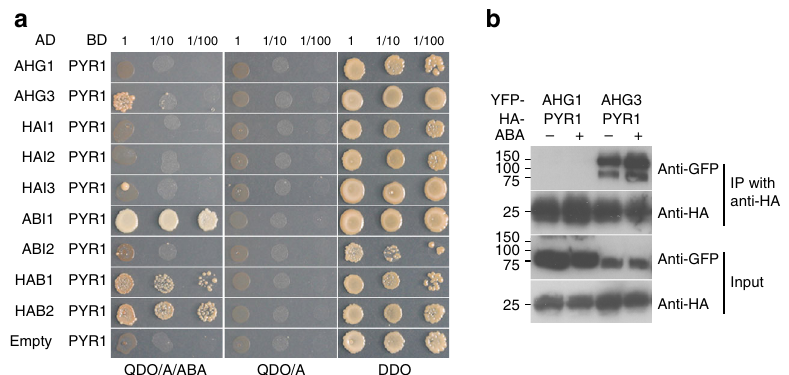
Fig. 1 Physical interaction of group A PP2Cs with PYR1. a Yeast two-hybrid analysis of group A PP2Cs with PYR1. Y2H gold cells transformed with GAL4BD-PYR1 and GAL4AD-PP2Cs, as indicated. A series of tenfold serial dilutions were spotted onto DDO (Double dropout medium: SD/-Leu/-Trp), QDO/A (Quadruple dropout medium: SD/-Ade/-His/-Leu/-Trp supplemented with Aureobasidin A) and QDO/A/ABA (Quadruple dropout medium: SD/-Ade/-His/-Leu/-Trp supplemented with Aureobasidin A and ABA) medium agar plates for 7 days after inoculation. b Interaction of PYR1 with AHG1 and AHG3. HA-PYR1 co-immunoprecipitates with YFP-AHG3, but not YFP-AHG1, in an ABA-dependent manner. Total protein extracts from transformed N. benthamiana leaves were harvested 4 days after inoculation and were treated with or without 100 μ M ABA for 24 h before harvesting. After co- immunoprecipitation using anti-HA matrix, the input and the immunoprecipitated samples were detected with anti-GFP and anti-HA